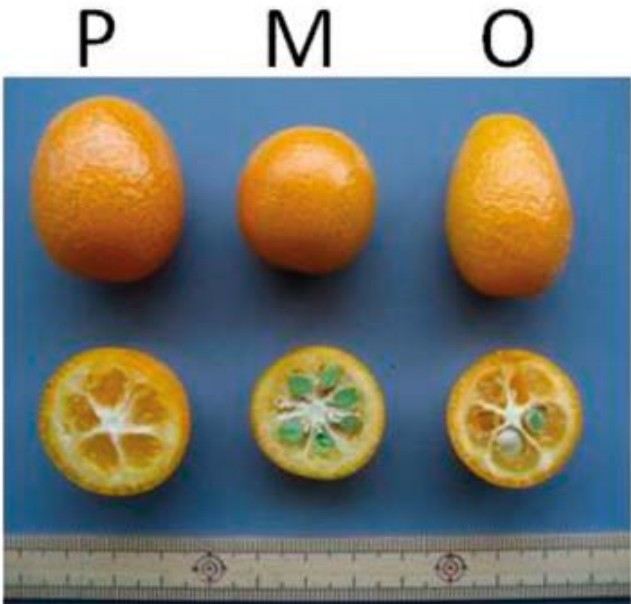
Fig. 5 - Triploid seedless kumquat ‘Puchimaru’ and diploid seedy Meiwa kumquat and Oval kumquat. P= Puchimaru, M= Meiwa kumquat, and O=